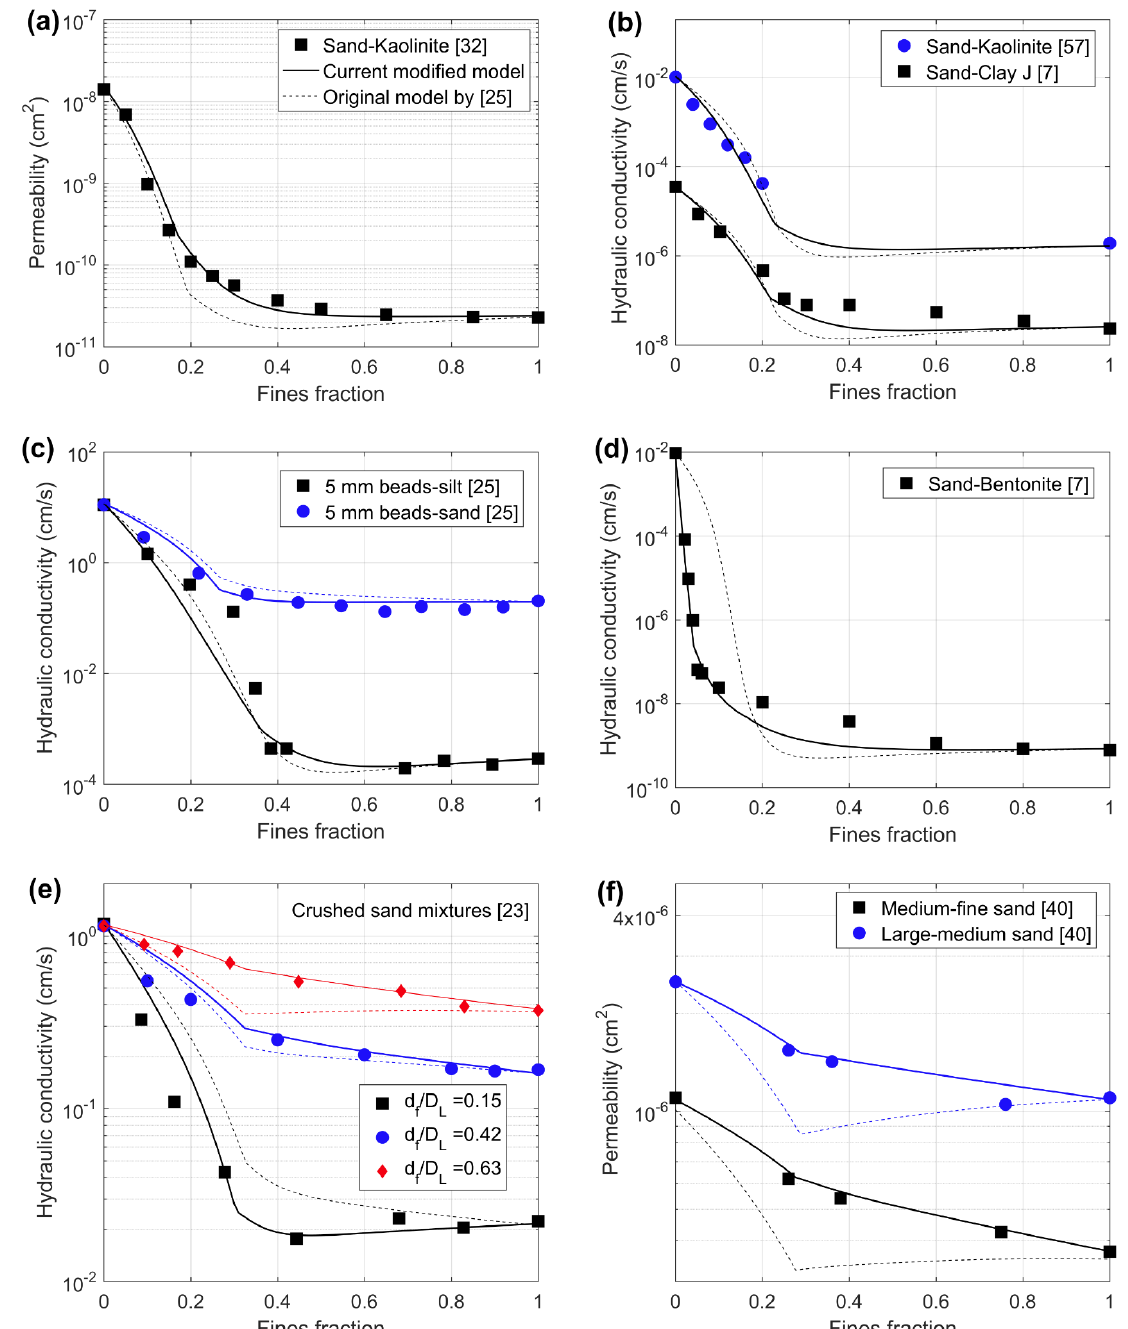
Figure 8. Hydraulic conductivity (or permeability) as function of fines fraction for various binary mixed soils. Subfigures ( a )–( f ) show different examples from different binary mixed soils where the source of the data is shown in the right upper corner. The prediction of the current model (Equations (13)–(18) and (19)–(21)) is shown in bold solid curves while the prediction using the approach presented by Zhang et al. [25] (Equations (1)–(3) and (19)–(21)) is shown in dashed curves.